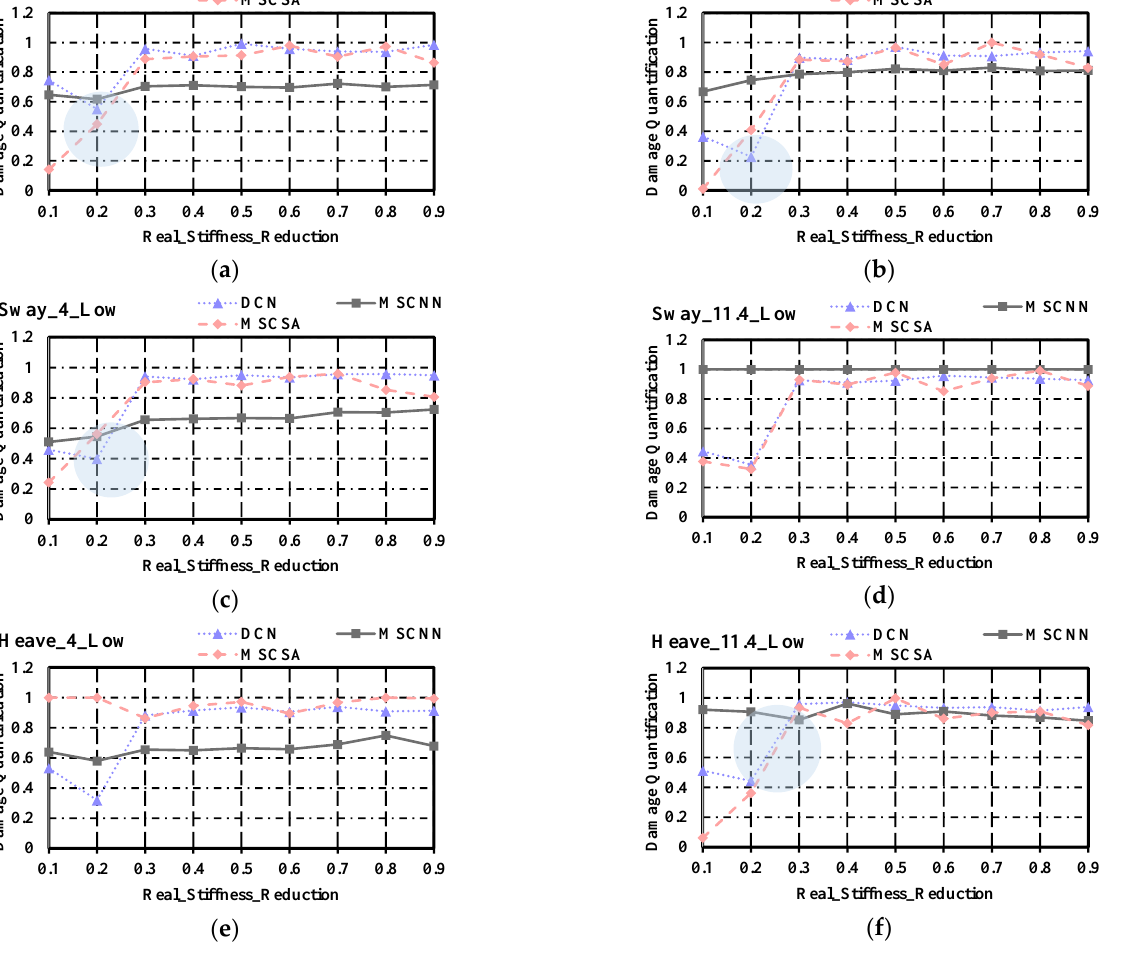
Figure 6. Damage quantification by Euclidean similarity. ( a ) Surge acceleration under 4 m/s, measured by the lower sensor. ( b ) Surge acceleration under 11.4 m/s, measured by the lower sensor. ( c ) Sway acceleration under 4 m/s, measured by the lower sensor. ( d ) Sway acceleration under 11.4 m/s, measured by the lower sensor. ( e ) Heave acceleration under 4 m/s, measured by the lower sensor. ( f ) Heave acceleration under 11.4 m/s, measured by the lower sensor. Monotonicity was used as a metric to evaluate the performance of the quantified